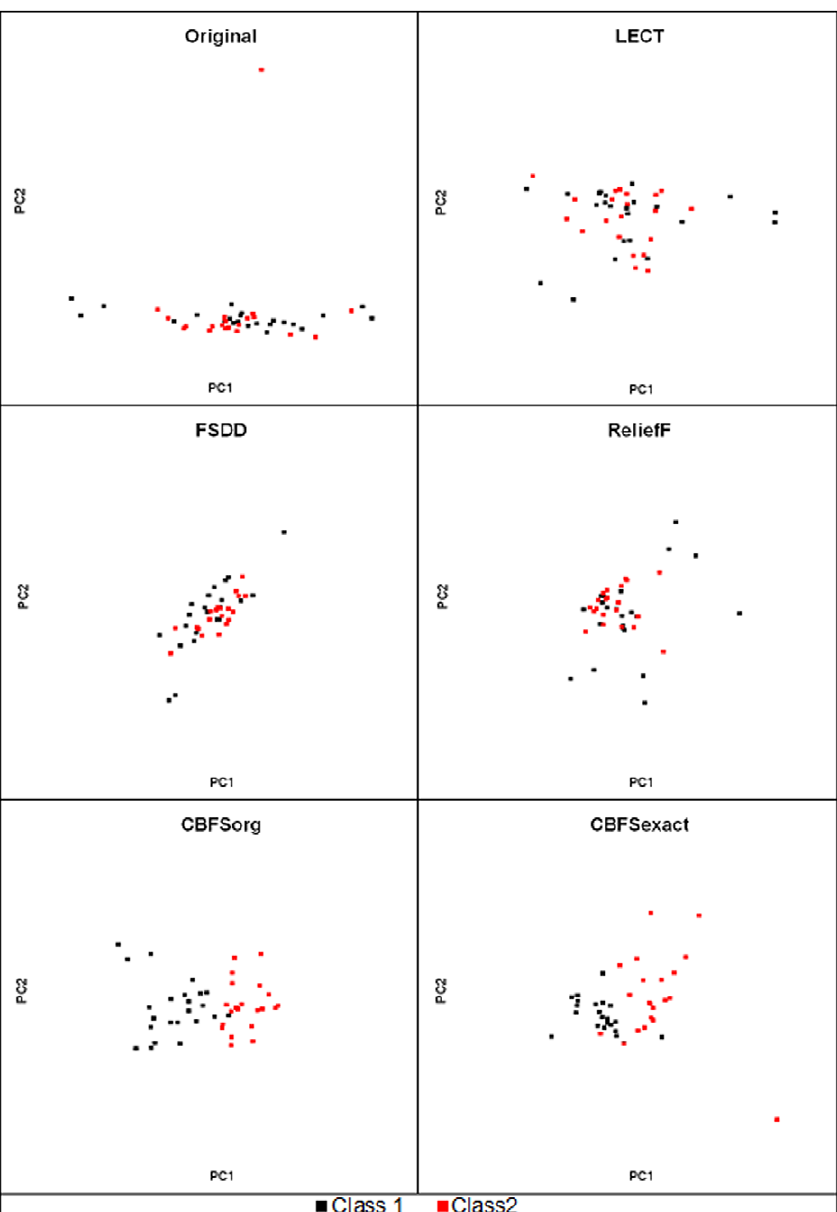
Figure 7. PCA analysis for feature selection results for the Arcene dataset. Congestion areas of red and black points are narrow in CBFS graphs comparing with the others.